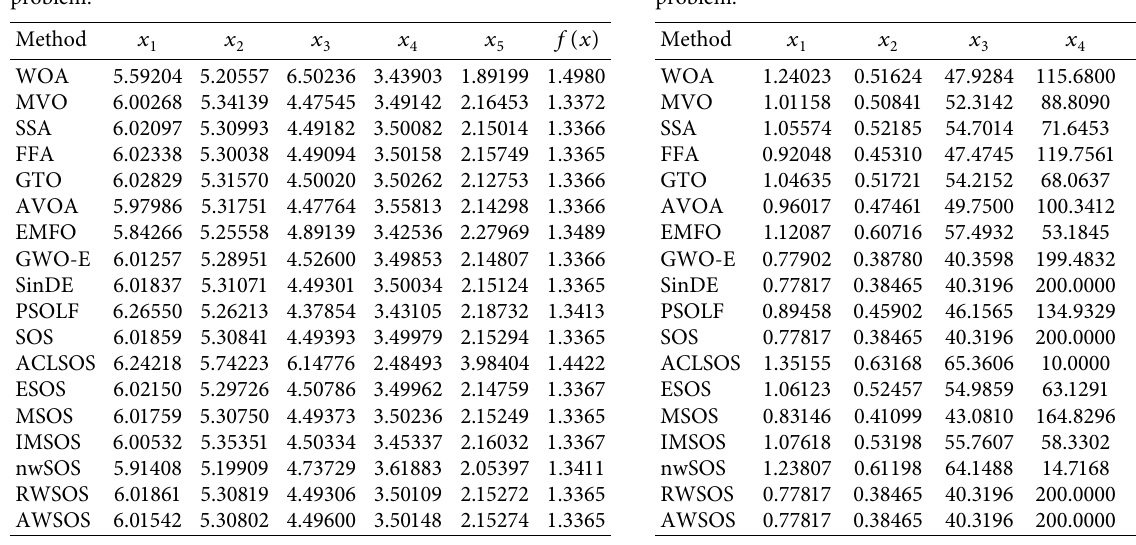
Table 24: Comparison of the results on the pressure vessel design